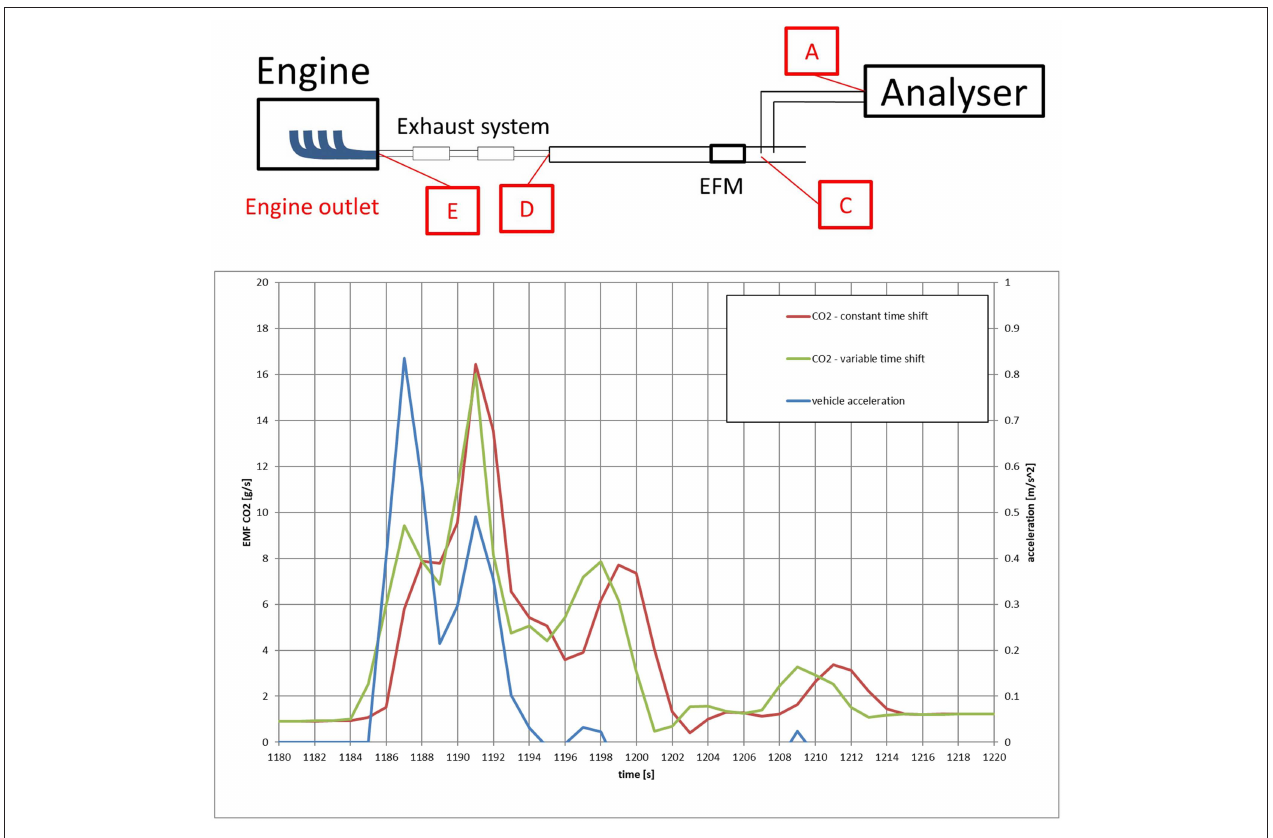
FIGURE 3 | Schematic diagram of a PEMS and comparison of CO 2 emission mass flow.